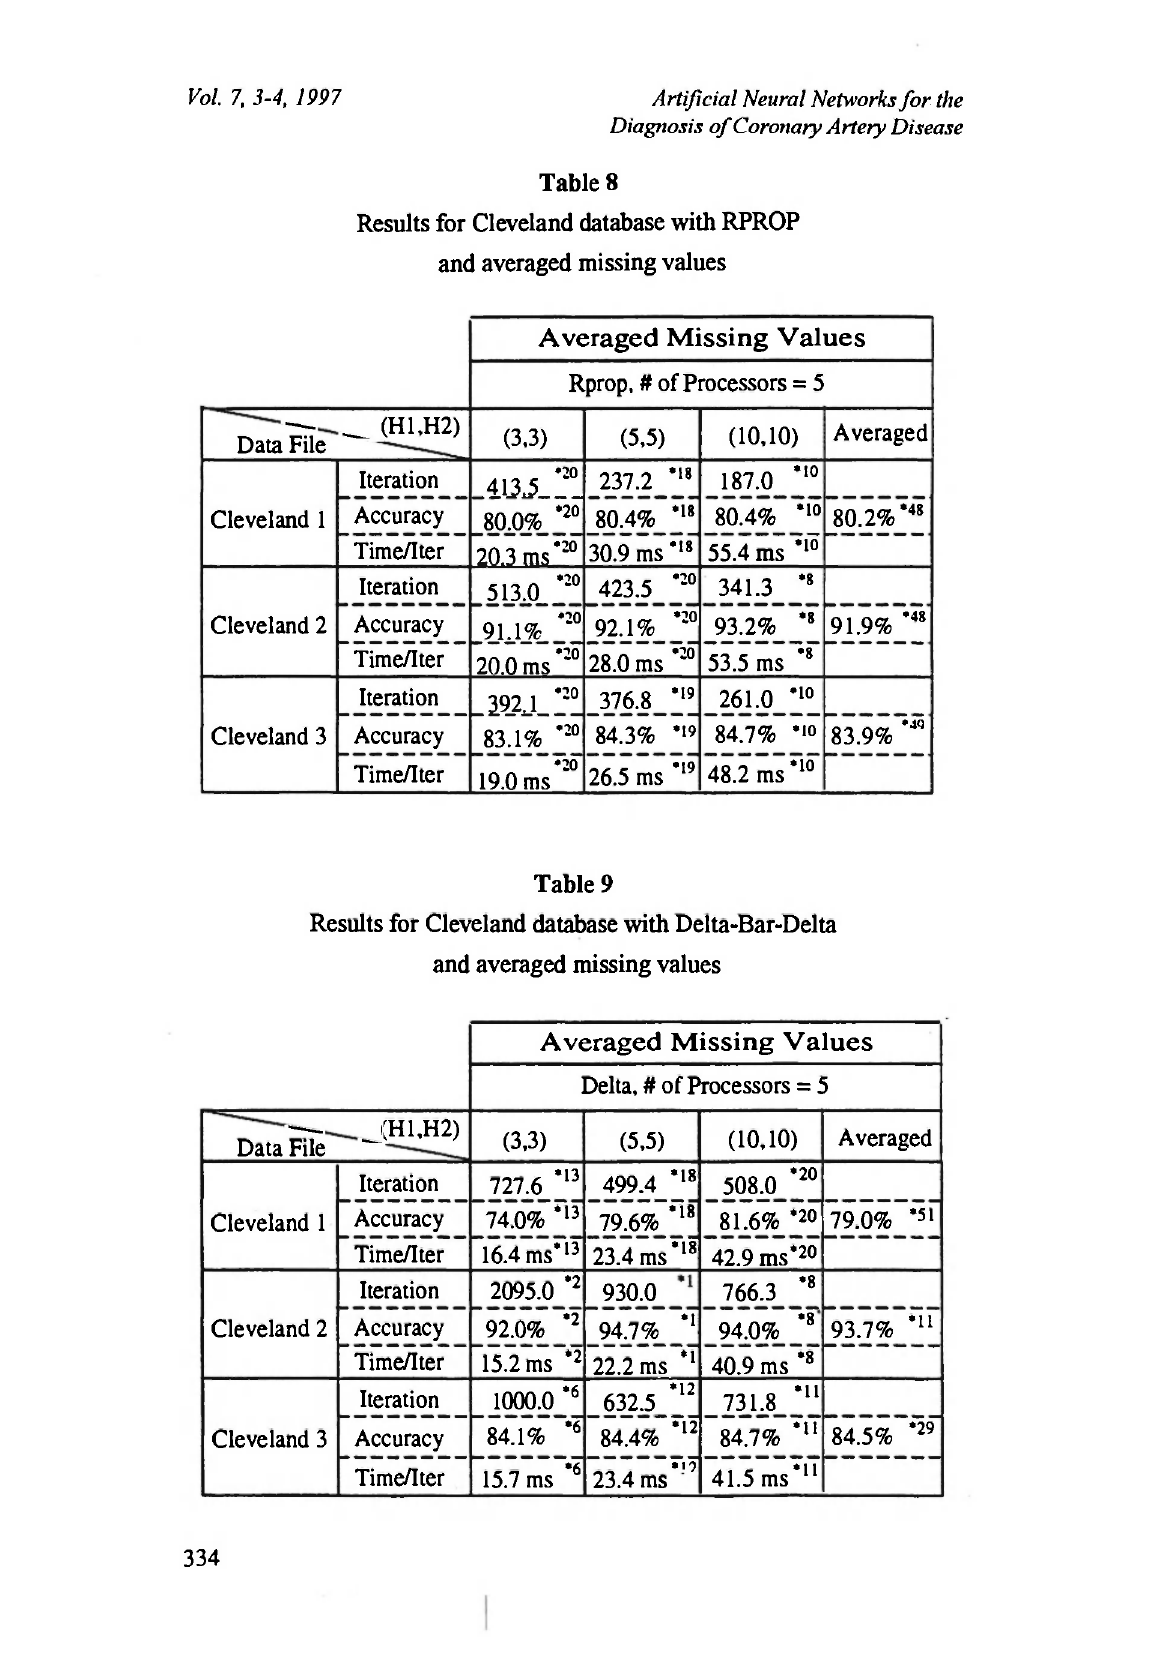
Results for Cleveland database with Delta-Bar-Delta and averaged missing